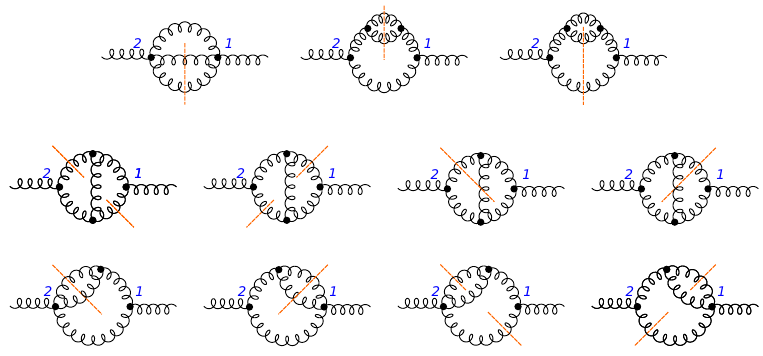
. In each diagram the dashed orange line cuts through two 2 (cid:0) 2 21